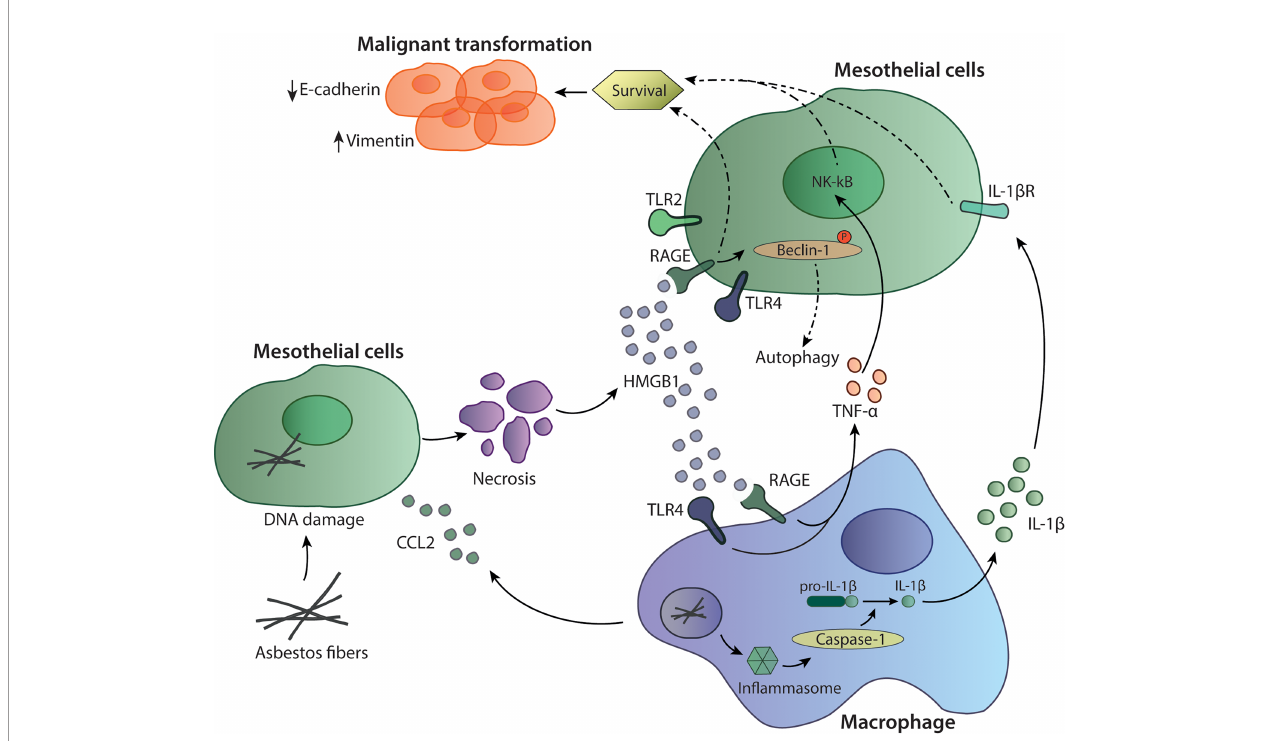
FIGURE 1 | Mechanisms of asbestos-induced carcinogenesis. Asbestos fi bers reach the mesothelial cells where they can induce cell death and the release of in fl ammatory mediators such as HMGB1 and CCL2. The recruited macrophages are activated through HMGB1 binding to TLR4 and RAGE to induce TNF- a or by in fl ammasome activation through asbestos fi bers. Activation of caspase-1 and cleavage of pro-IL-1 b to the active form IL-1 b can lead to further survival signals in mesothelial cells. HMGB1 can also bind to TLR4 and RAGE expressed on mesothelial cells supporting survival of those